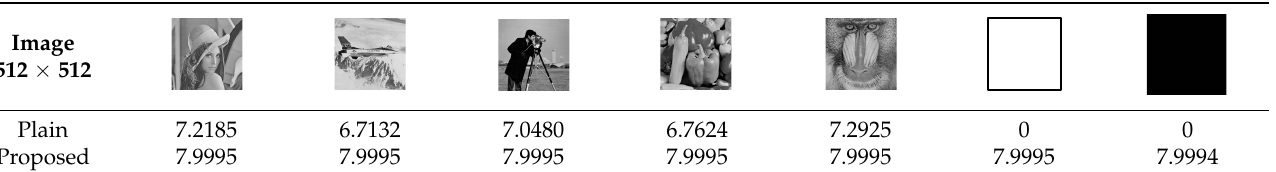
Table 5. Results of Information entropy.